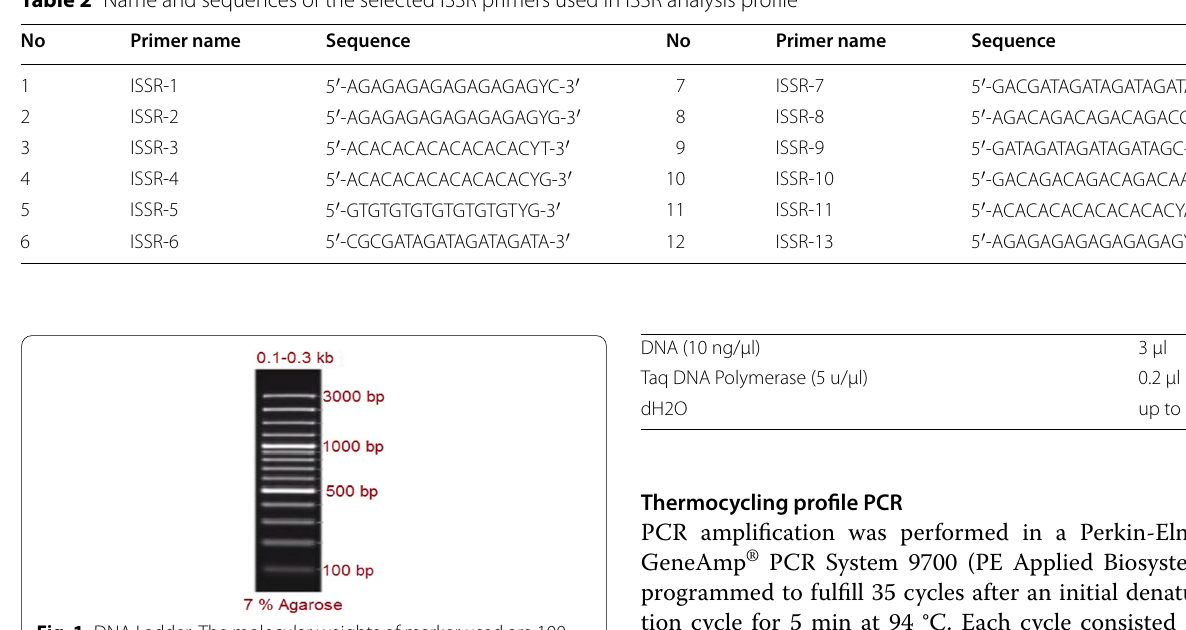
Fig. 1 DNA Ladder: The molecular weights of marker used are 100, 200, 300, 400, 500, 600, 700, 800, 900, 1000, 1200, 1500, 2000 and 3000 bp,